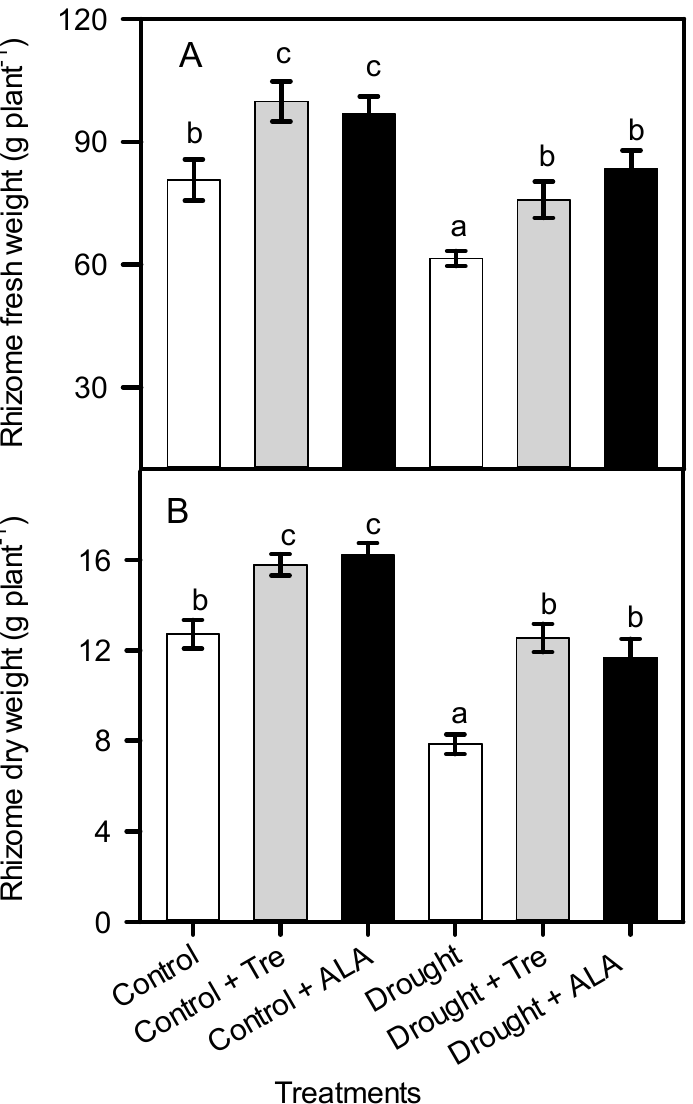
Figure 3. Rhizome fresh weight ( A ) and dry weight ( B ) for well-watered (100% FC, Control) and drought-stressed (65% FC, Drought) Alpinia zerumbet treated with foliar applications of water alone, 25 mM trehalose (Tre) or 10 mg L − 1 5-aminolevulinic acid (ALA). Values are means ± S.E. ( n = 6). Different letters above the bars indicate significant differences based on LSD analysis at p < 0.05.